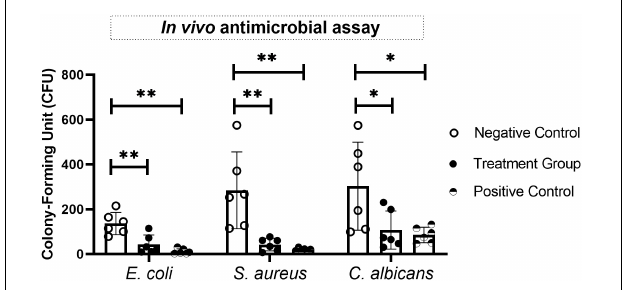
FIGURE 7 | Evaluation of in vivo antimicrobial effects of synthetic antimicrobial peptides (AMPs) on various bacteria and fungi in a skin infection mice model. The most effective antibacterial (CecB against Escherichia coli and Staphylococcus aureus ) and antifungal (MorA against Candida albicans ) agents in the in vitro assays were examined in this study, and the antimicrobial activities were expressed as CFU per skin sample. Statistical analyses were performed by t -test, and asterisks indicate significant difference ( ∗ p ≤ 0.05, ∗∗ p ≤